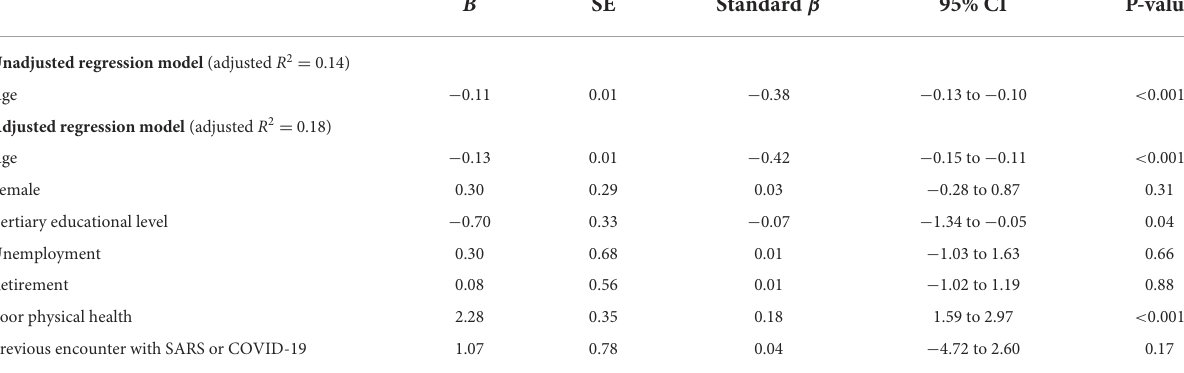
TABLE 2 Linear regression analysis of associations between age and K6 total